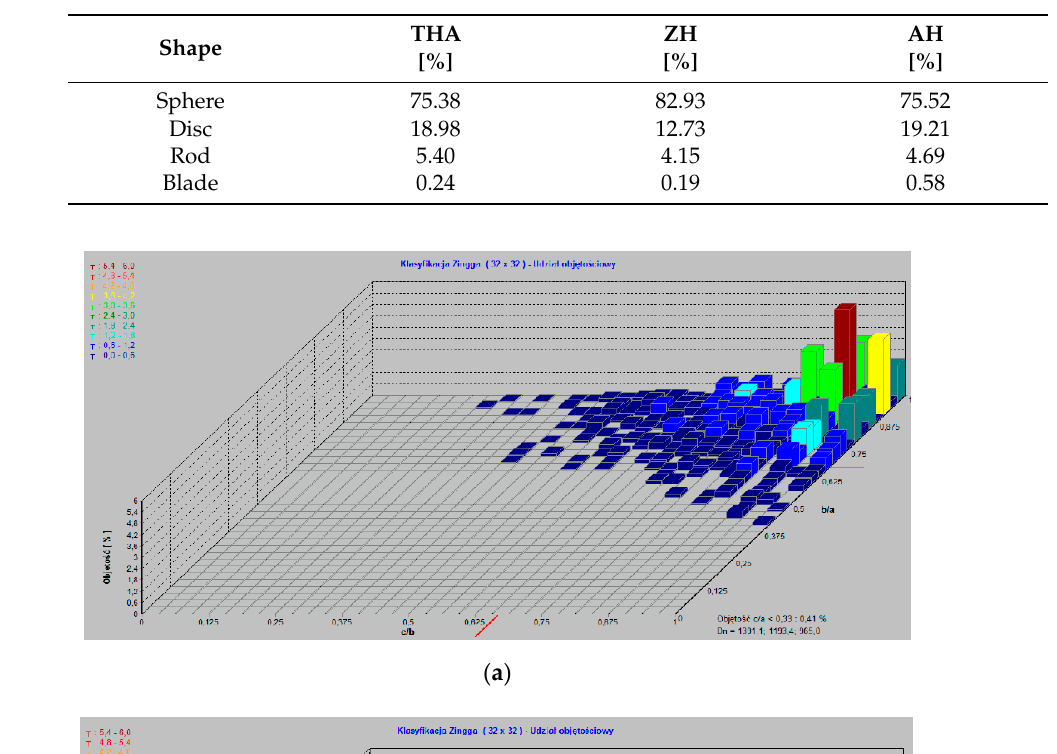
( f ) Figure 5. SEM scans of ( a ) THA, ( b ) ZH and ( c ) THA before the sorption process; after the sorption process of the Cu(II) complex with EDDS: ( d ) THA, ( e ) ZH and ( f ) THA. As indicated by the analysis of the microscopic scans showing the hydrogels before the sorption process, they differ significantly in their surface morphology. The THA and ZH hydrogels exhibit a clearly loose, rough and granular structure with visible shapeless fragments (Figure 5a,b), in contrast to the AH hydrogel, whose structure is rather com- pact, folded and regular (Figure 5c,f). In [30–32] as well, the dense, smooth surface of the hydrogels was confirmed. As shown by the SEM analysis after the sorption of Cu(II)- EDDS complexes on the above-mentioned hydrogels, the sorbent surface was partially smoothed (Figure 5e,f) [33].